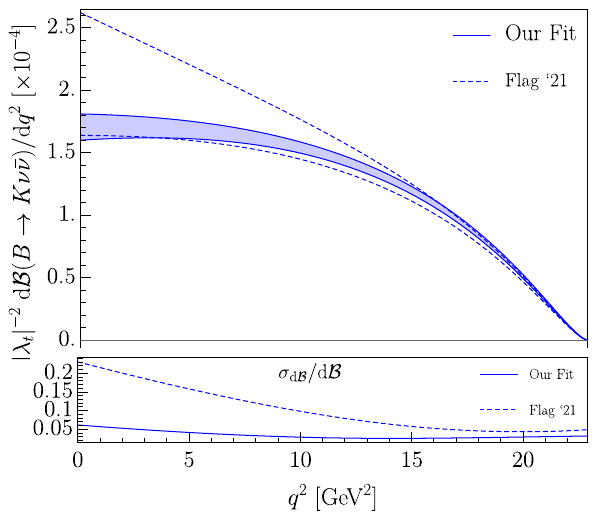
Fig. 2 Rescaled differential branching fraction | λ t | − 2 d B ( B + → K + ν ¯ ν)/ d q 2 is plotted by using the form factor f + ( q 2 ) from the FLAG review [35], and by using the one discussed in this letter. The lower panel shows the relative uncertainty on this quantity as a function of q 2 using the FLAG form factors